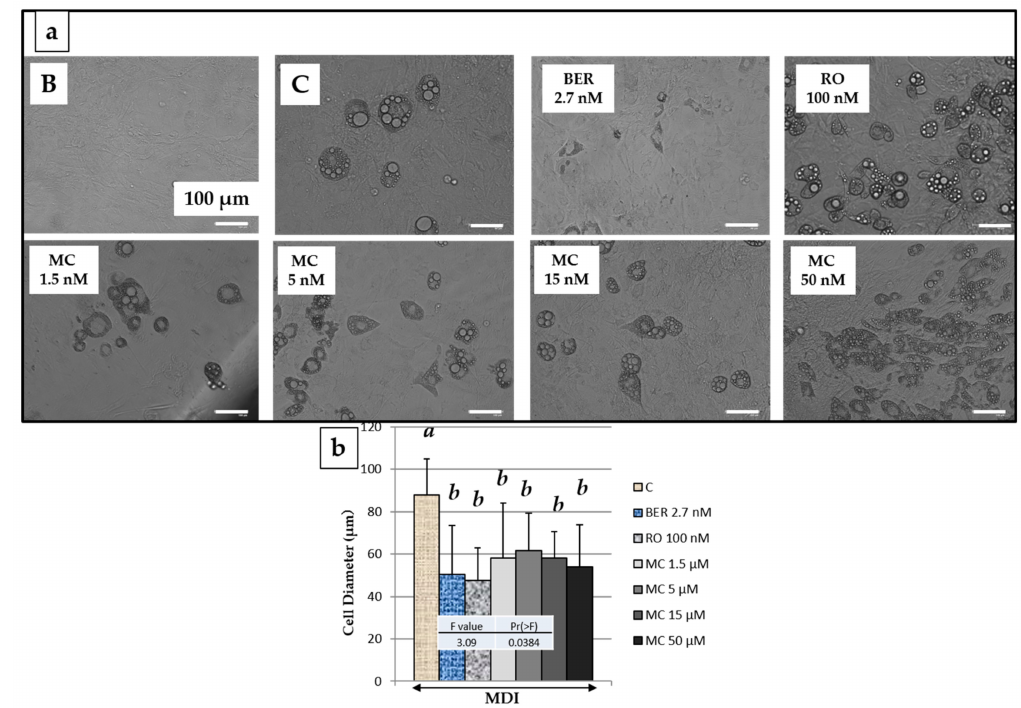
Figure 4. Images and the diameter of 3T3-L1 cells on the say 8 with reference compounds or methylcubelin (MC) of various concentrations. ( a ) Images of 3T3-L1 cells treated with corresponding conditions; ( b ) Cell diameters were determined using Image J software. B (Black): Undi ff erentiated cells without the addition of the MDI mixture. C (Control): cells with the addition of the MDI Arrow (solid line) indicates the addition of the MDI mixture. Data are presented as the mean ± SD from 100 cells of three independent pictures. The same letters indicate that there are no di ff erences between those groups, and di ff erent letters indicate significant di ff erences ( P <